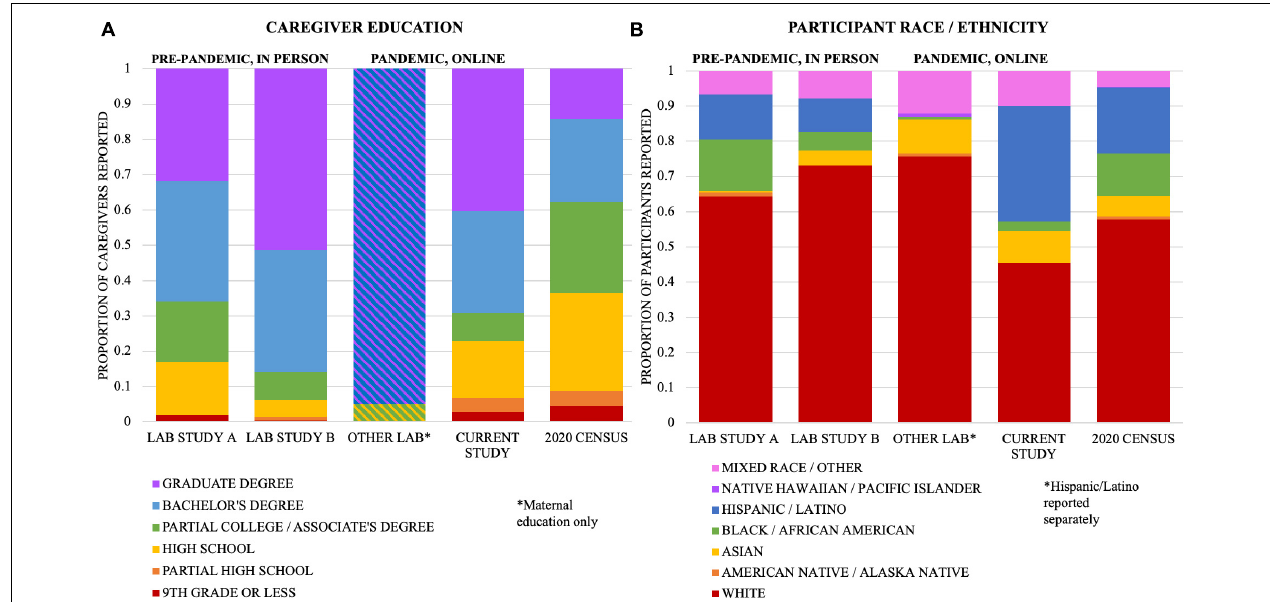
FIGURE 1 | Comparison to two studies from our lab conducted prior to the pandemic (Lab Study A, Ozernov-Palchik et al., 2017; Lab Study B, Pollack et al., 2021), one from another lab conducting a similar study during the pandemic (Other Lab; Bambha and Casasola, 2021), and the 2020 US Census. For Lab Study B, we included all participants who completed any portion of the study. (A) Highest level of parental education attainment, including both parents, for all who responded (Lab Study A, N = 358; Lab Study B, N = 463; Other Lab [maternal only], N = 118; Current Study, N = 449). 2020 Census includes all adults 25 years and older. (B) Parent-reported race/ethnicity of the child, for all who responded (Lab Study A, N = 179; Lab Study B, N = 230; Other Lab, N = 115; Current Study, N = 231). Participants who identify as Hispanic/Latino are counted in that category, regardless of race. Other categories reflect that race alone (not Hispanic/Latino). *Bambha and Casasola reported maternal education only: obtained high school degree (118/118), obtained 4-year college degree or above (112/118); and reported Hispanic/Latino separately from race (15/115 were Hispanic or Latino).